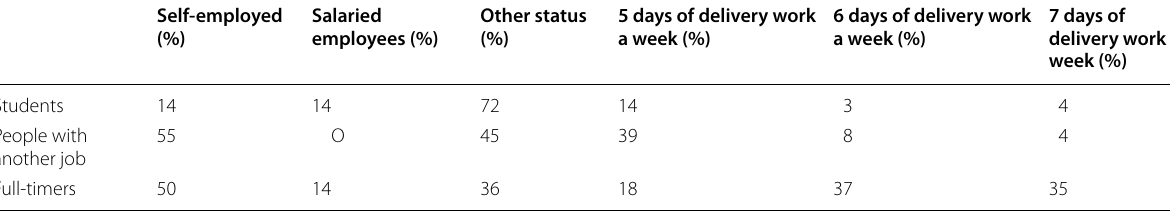
Table 4 Working conditions of the couriers in 2020. Source : Author’s survey Self-employed (%)